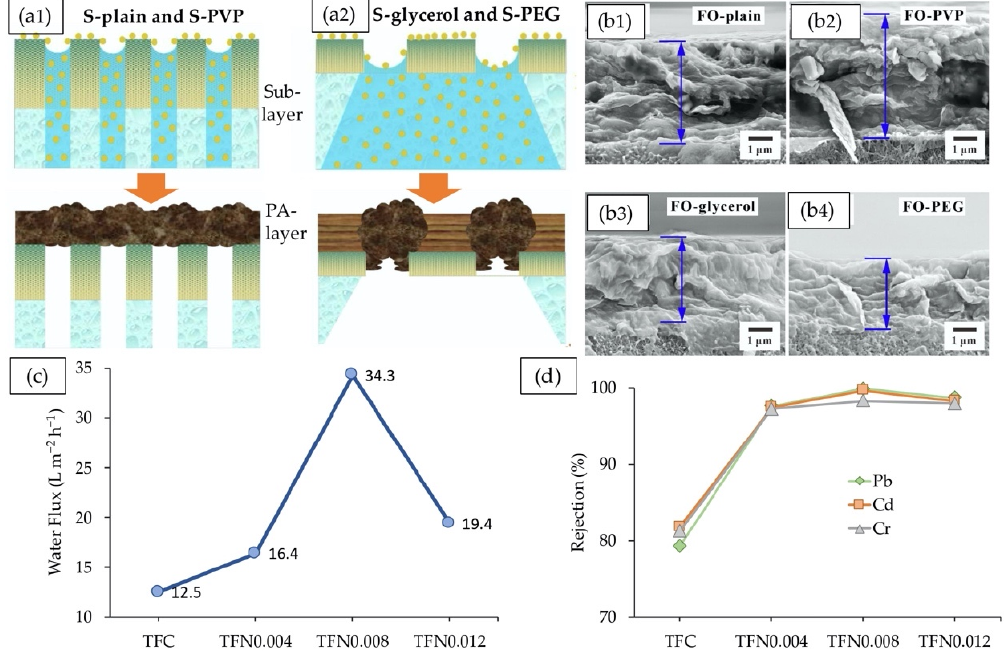
Figure 6. The effect of different structures of substrates on PA layer formation ( a1 , a2 ) and formation foulants layer on the membrane surfaces ( b1 – b4 ) [79]. ( c ) Water flux behavior and ( d ) rejection of heavy metals from synthetic wastewater using different membranes [159].